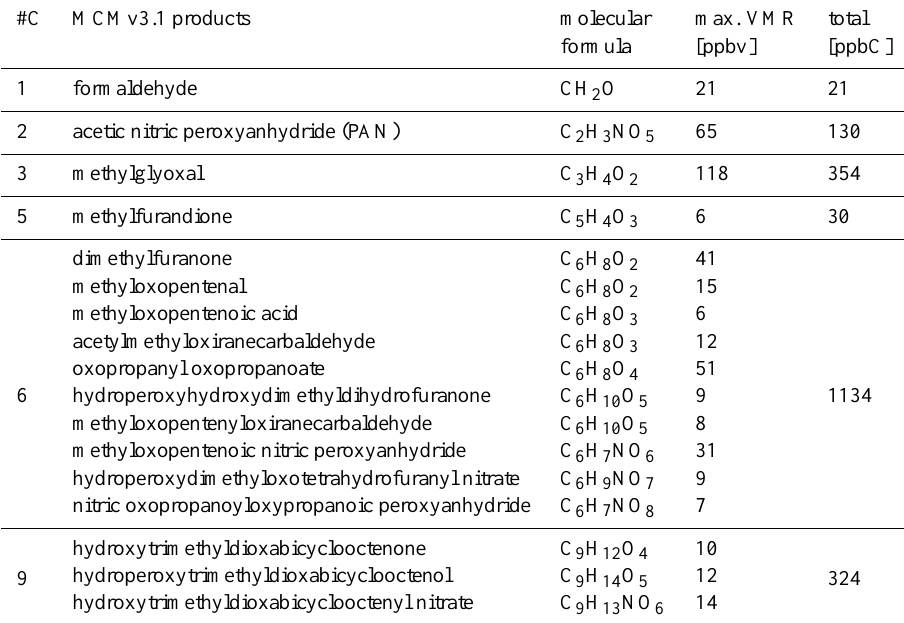
Table 2. Overview of all MCMv3.1 predicted TMB degradation products with a molar yield > 1%. The products are grouped according to their number of carbon atoms n C . The predicted maximum volume mixing ratio (max. VMR) within the first 10h of reaction time during experiment 1a is also